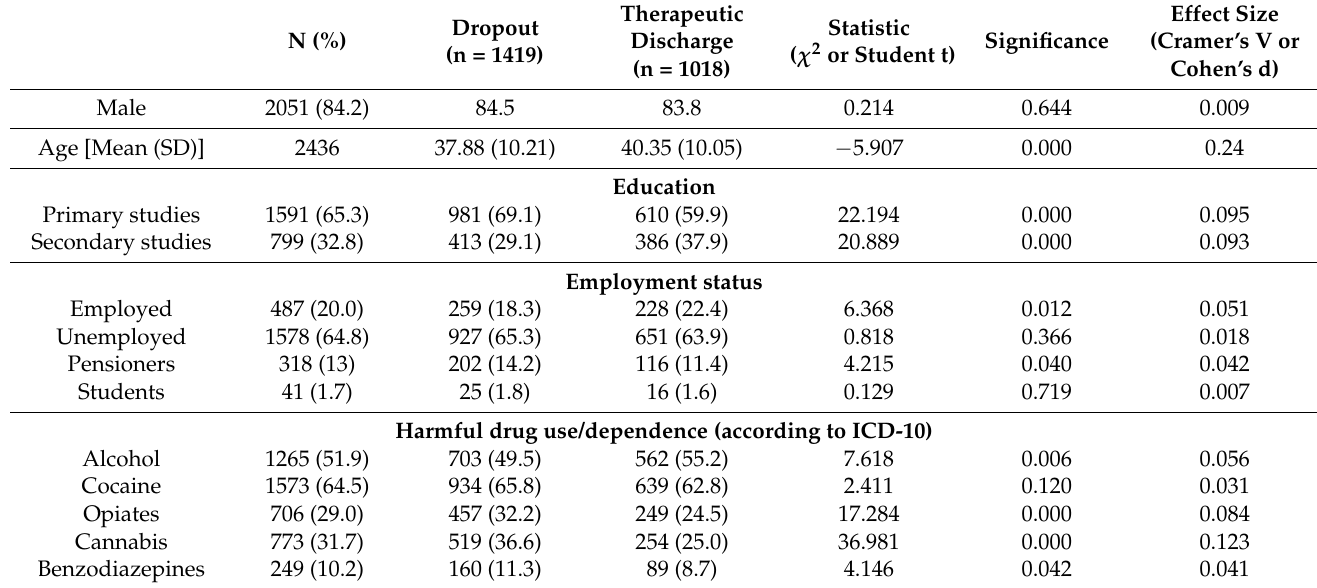
Table 1. Sociodemographic and substance use disorders according to type of discharge.